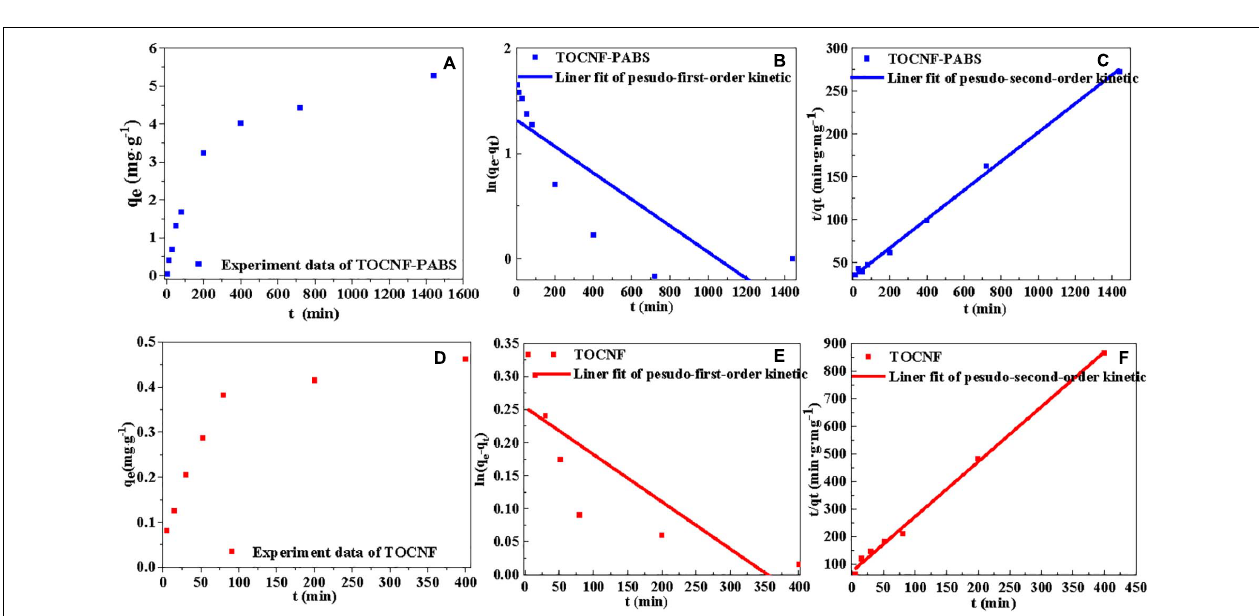
FIGURE 5 | Linear fitting curves of isotherm models (pseudo-first-order and pseudo-second-order kinetic models) for the adsorption of Cr(VI) onto TOCNF and TOCNF-PABS. (A) Effect of the adsorption time on the adsorption capacity of TOCNF-PABS; (B) Linear fitting curve of pseudo-first-order kinetic model for the adsorption of Cr(VI) onto TOCNF-PABS; (C) Linear fitting curve of pseudo-second-order kinetic model for the adsorption of Cr(VI) onto TOCNF-PABS; (D) Effect of the adsorption time on the adsorption capacity of TOCNF; (E) Linear fitting curve of pseudo-first-order kinetic model for the adsorption of Cr(VI) onto TOCNF; (F) Linear fitting curve of pseudo-second-order kinetic model for the adsorption of Cr(VI) onto TOCNF.